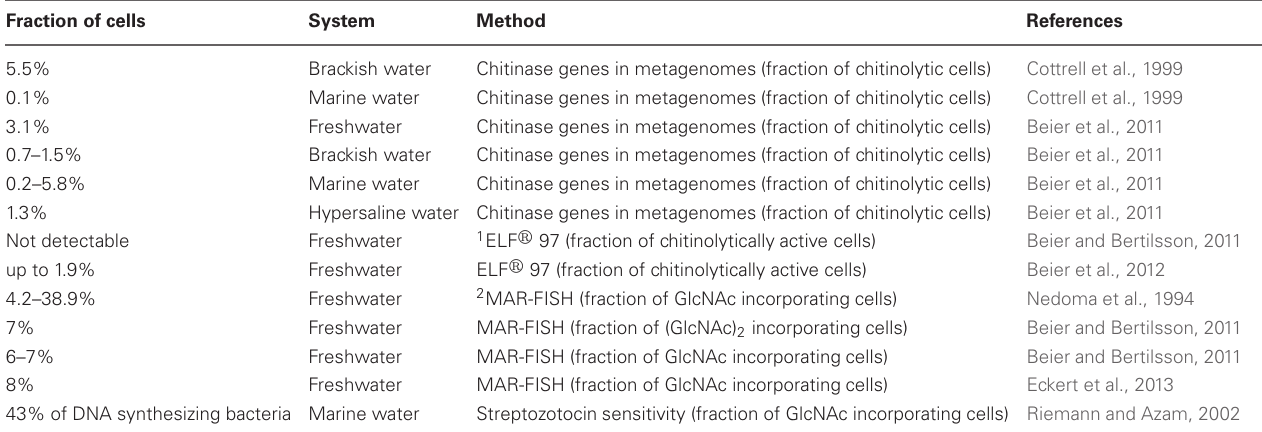
Table 1 | Fraction of chitinolytic, chitinolytically active, and chitin hydrolysis products incorporating cells (no results of culture-dependent studies are listed here, since quantitative values are likely strongly biased).